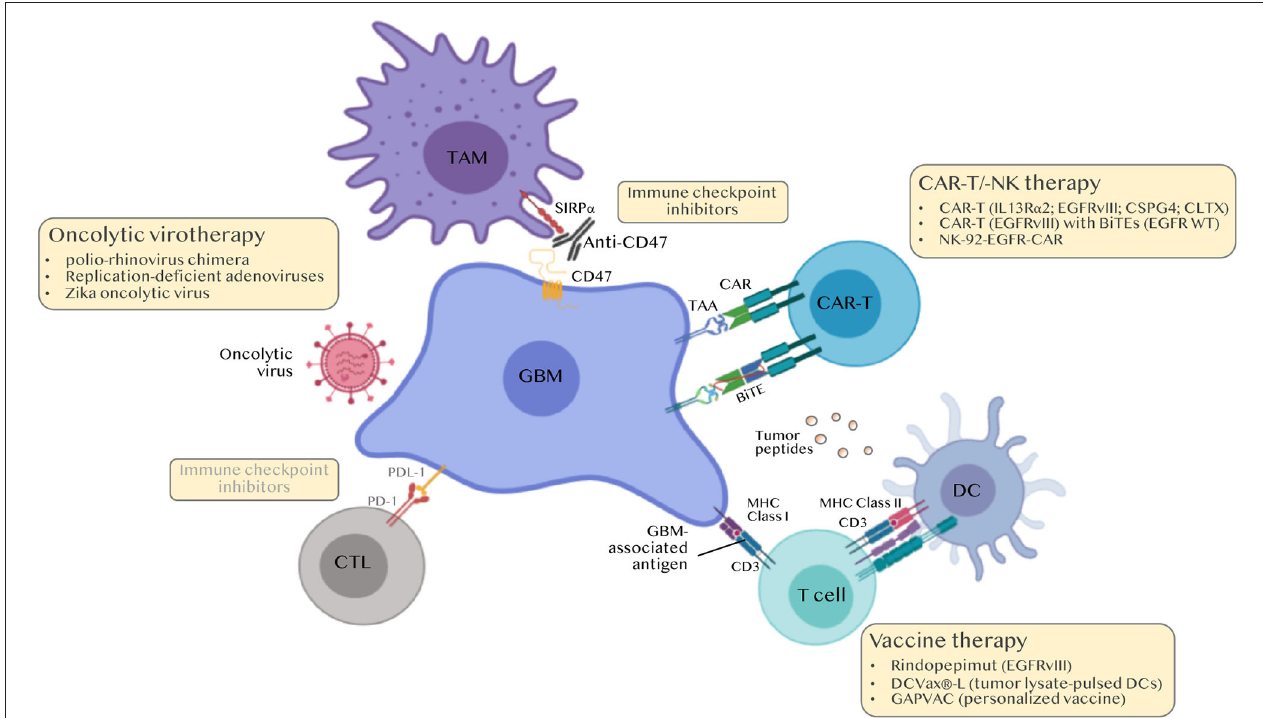
FIGURE 4 | Immunotherapies for the treatment of GBM. Classical immune checkpoint inhibitors (ICI) i.e., anti-PD-1/PDL-1 and anti-CTLA4 were ineffective in GBM. Current approaches include modulating TAMs (anti-CD47 to boost phagocytosis, nano-immunoconjugates to modulate TAM phenotype, aptamers to inhibit